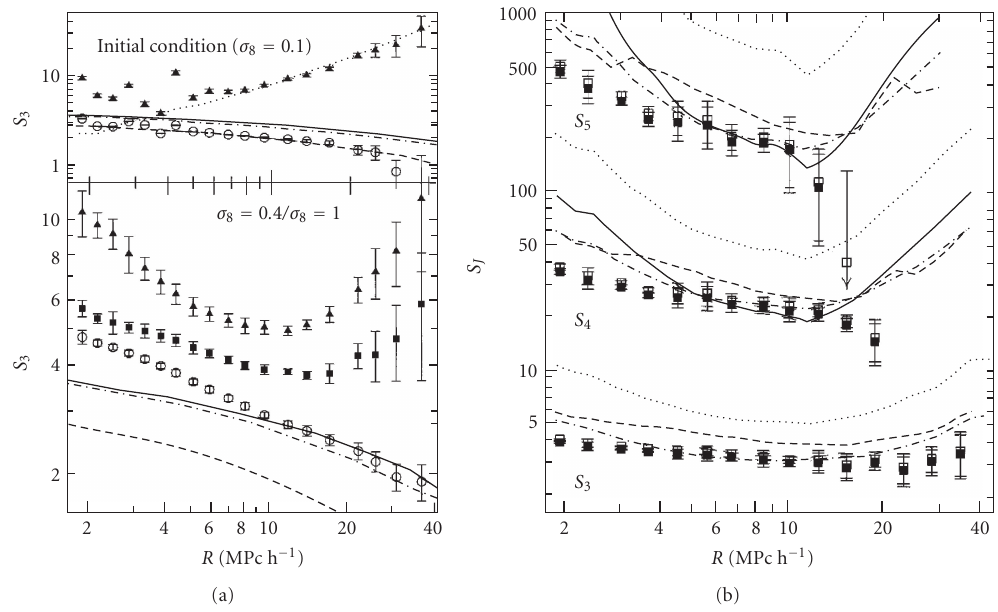
Figure 14: (a) Measurements of the skewness of the matter distribution in N-body simulations as a function of the smoothing scale R for the non-Gaussian texture model ( filled symbols ) and for Gaussian initial conditions ( open circles ). The time evolution is parametrized by the value of σ 8 , with the non-Gaussian results shown at σ 8 = 0 . 4 ( triangles ) and σ 8 = 1 ( squares ). Lines show di ff erent theoretical predictions. (b) Measurements of the third-, fourth- and fifth-order moments of the galaxy distribution in the APM Galaxy Survey, compared with the simulation results with non-Gaussian initial conditions with di ff erent bias assumptions, from the study by Gaztanaga and M¨ah¨onen in [163] (see the reference for further